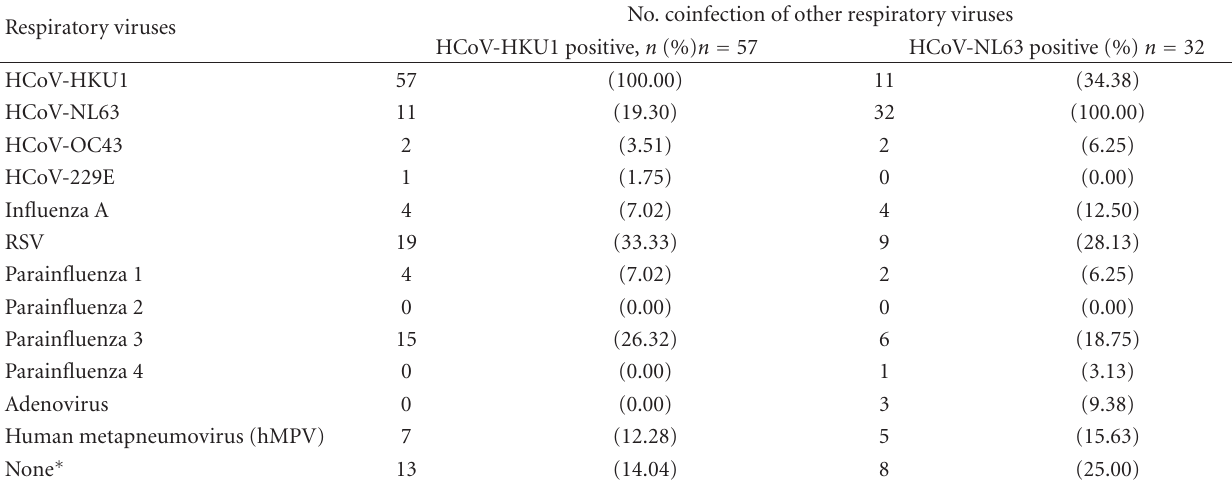
Table 2: Coinfection of HCoV-positive samples with other respiratory viruses.